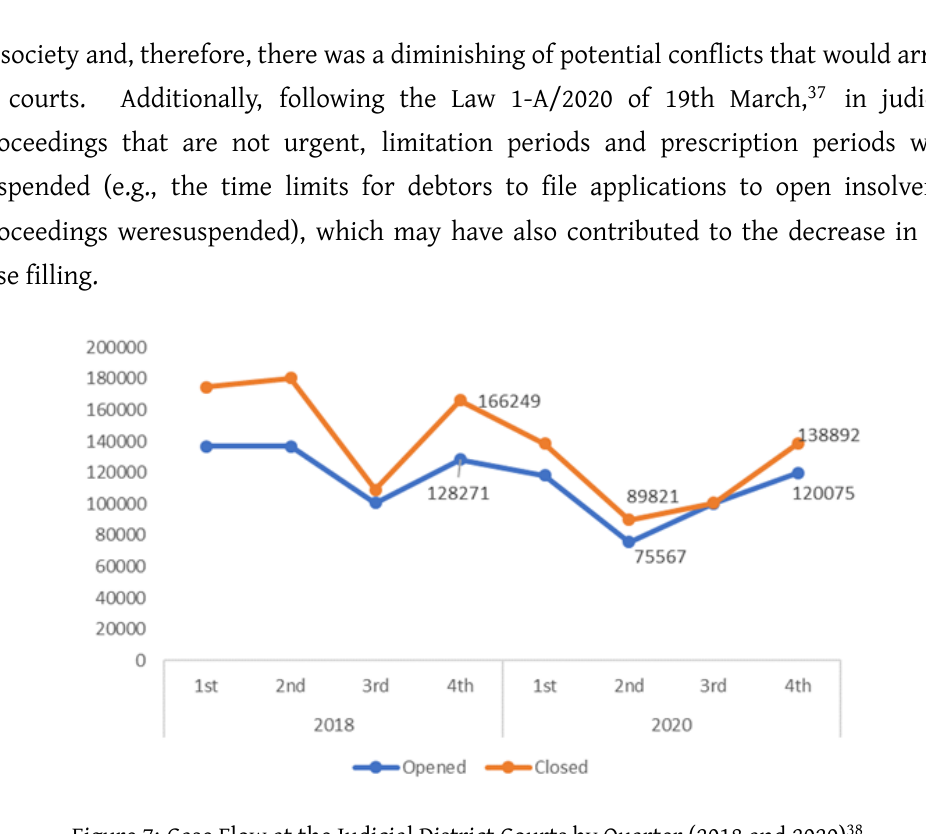
Figure 7: Case Flow at the Judicial District Courts by Quarter (2018 and 2020)